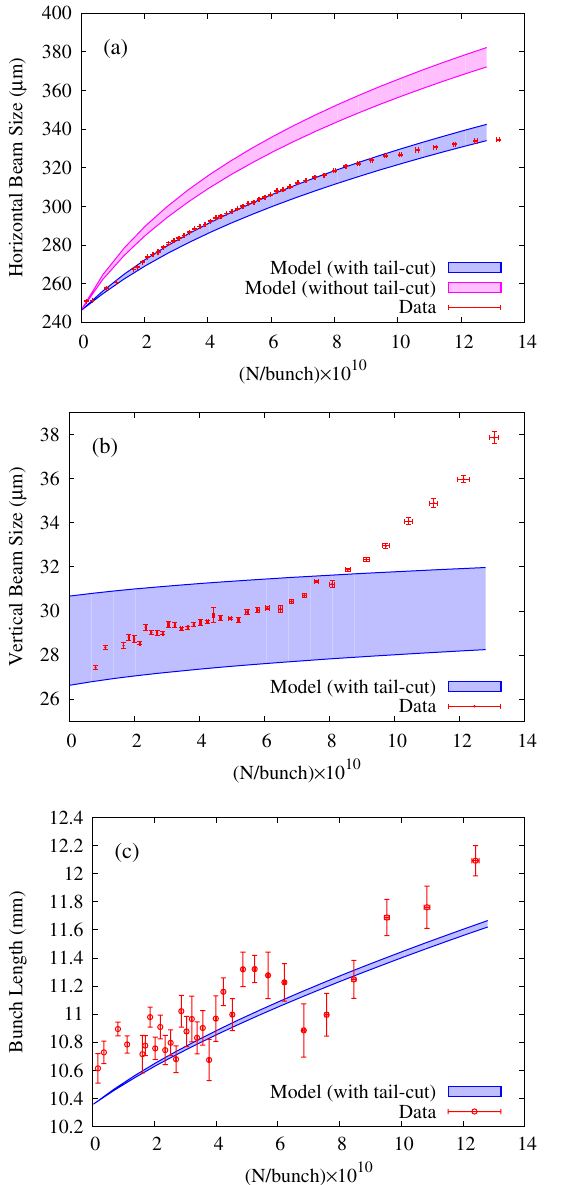
FIG. 13. (a) Horizontal, (b) vertical, and (c) longitudinal beam size versus current for e (cid:1) bunch with increased zero current vertical